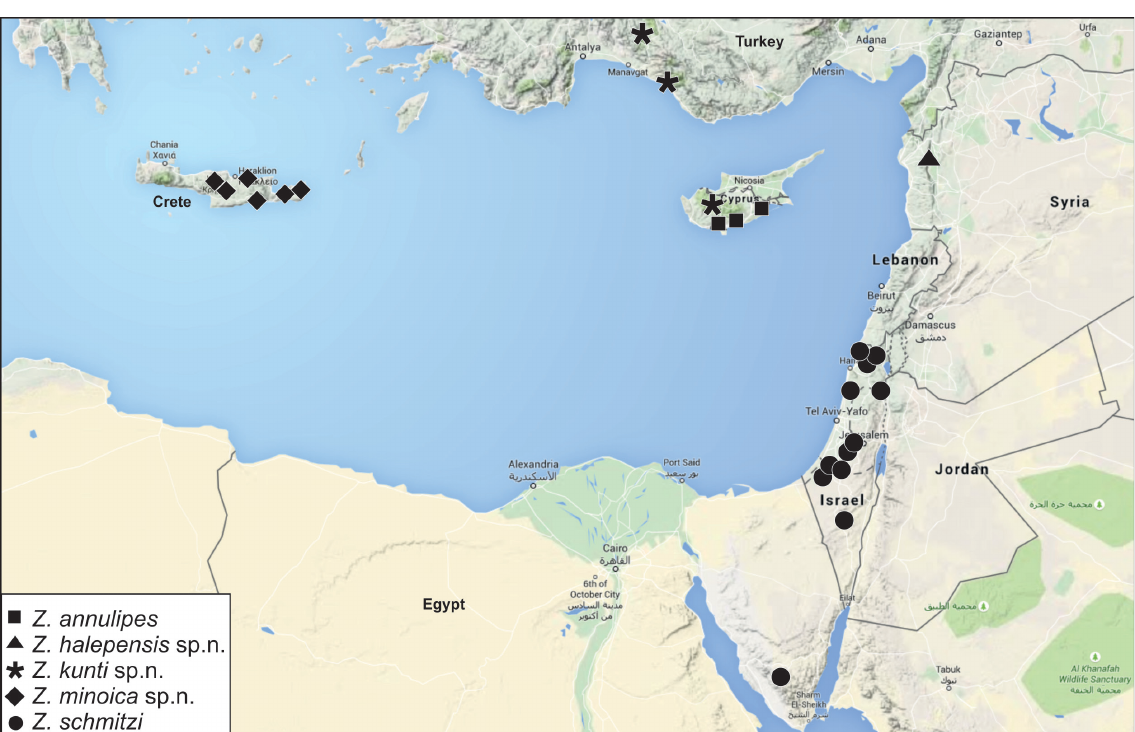
Fig. 46. Distribution of Zaitunia schmitzi and Zaitunia annulipes species groups.